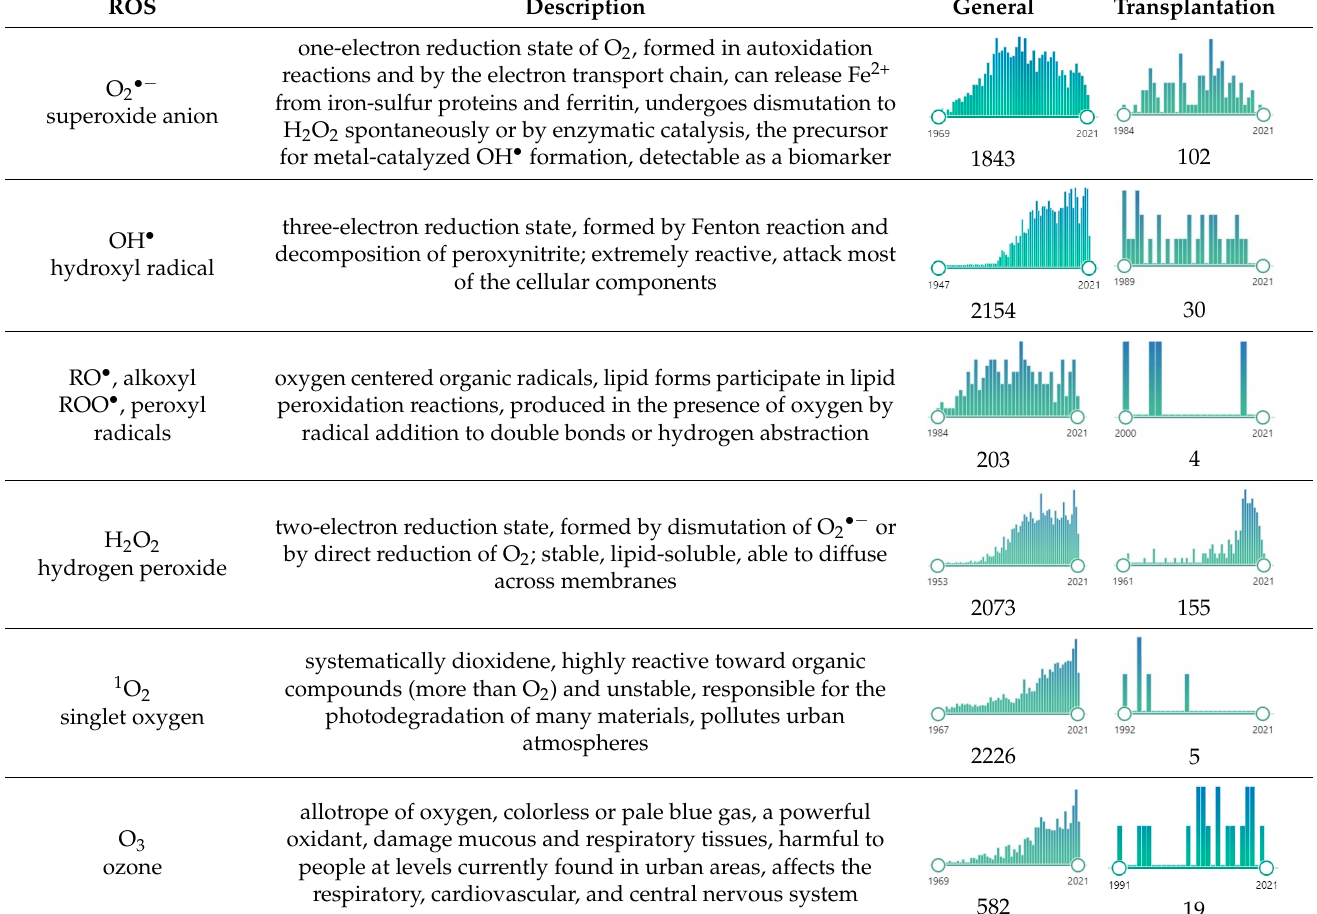
Table 1. Reactive oxygen species—description and research interest.